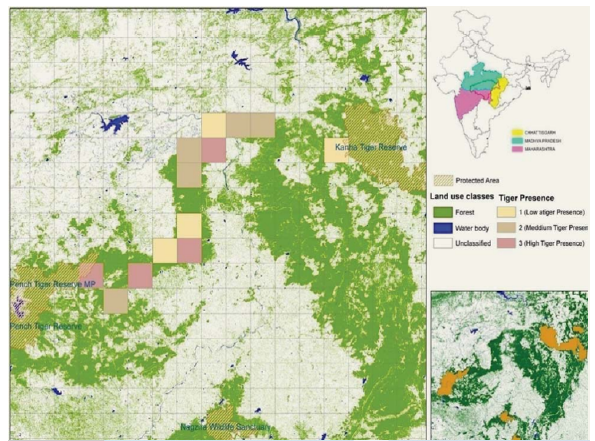
Figure 3: Land Use classes and Tiger